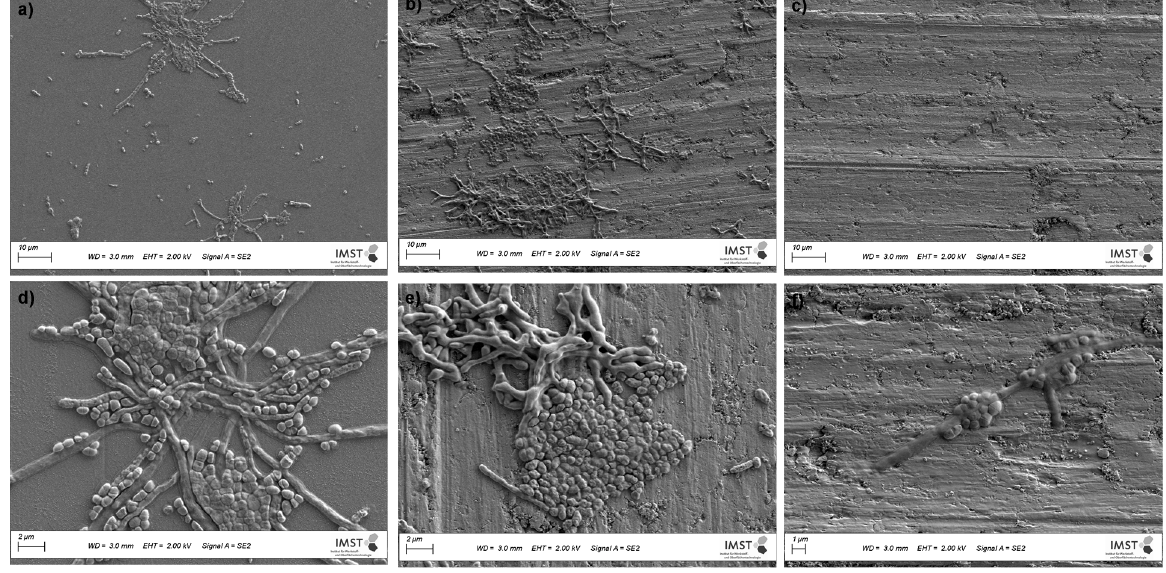
Figure 9. SEM secondary electron micrographs of dental plaque cultures on coverslips ( a , d ), as-received TiCP ( b , e ), and polySBMA-coated TiCP ( c , f ).